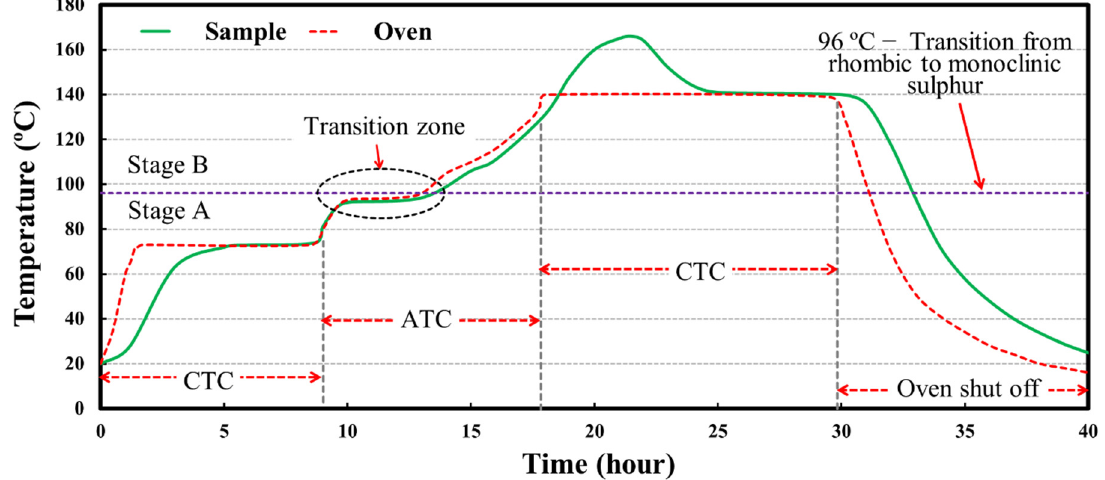
Figure 8. Example thermograph of a sample that passed the transition temperature (shown from initiation to completion of test).